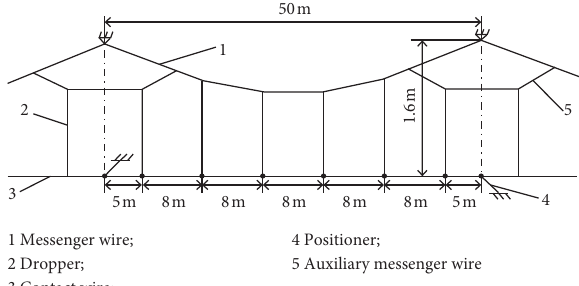
Figure 1: The stitched catenary system. 1. Messenger wire. 2. Dropper. 3. Contact wire. 4. Positioner. 5. Auxilary messenger